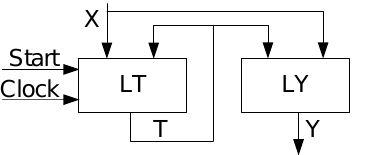
Figure 1. Structural diagram of LUT-based P Mealy